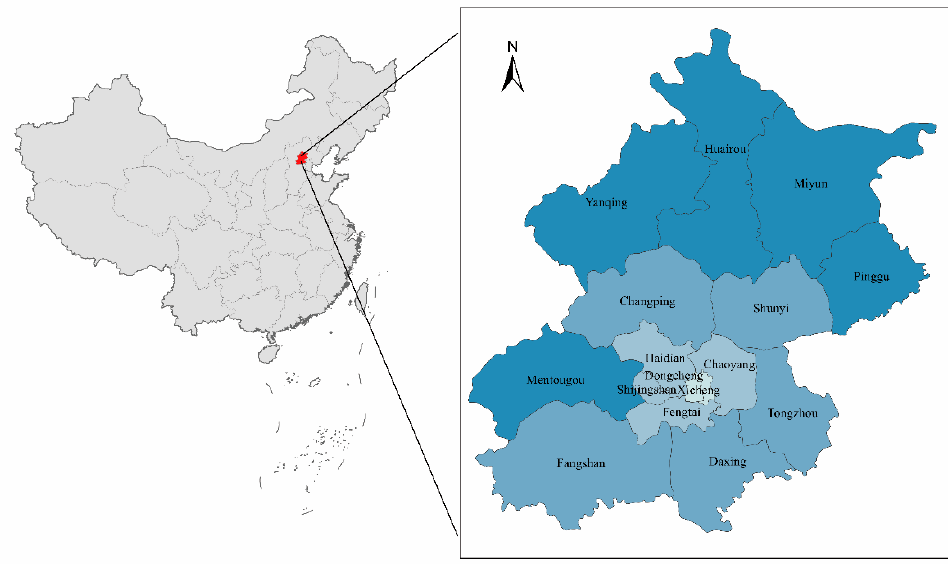
Figure 1. The spatial location of Beijing and its administrative division.